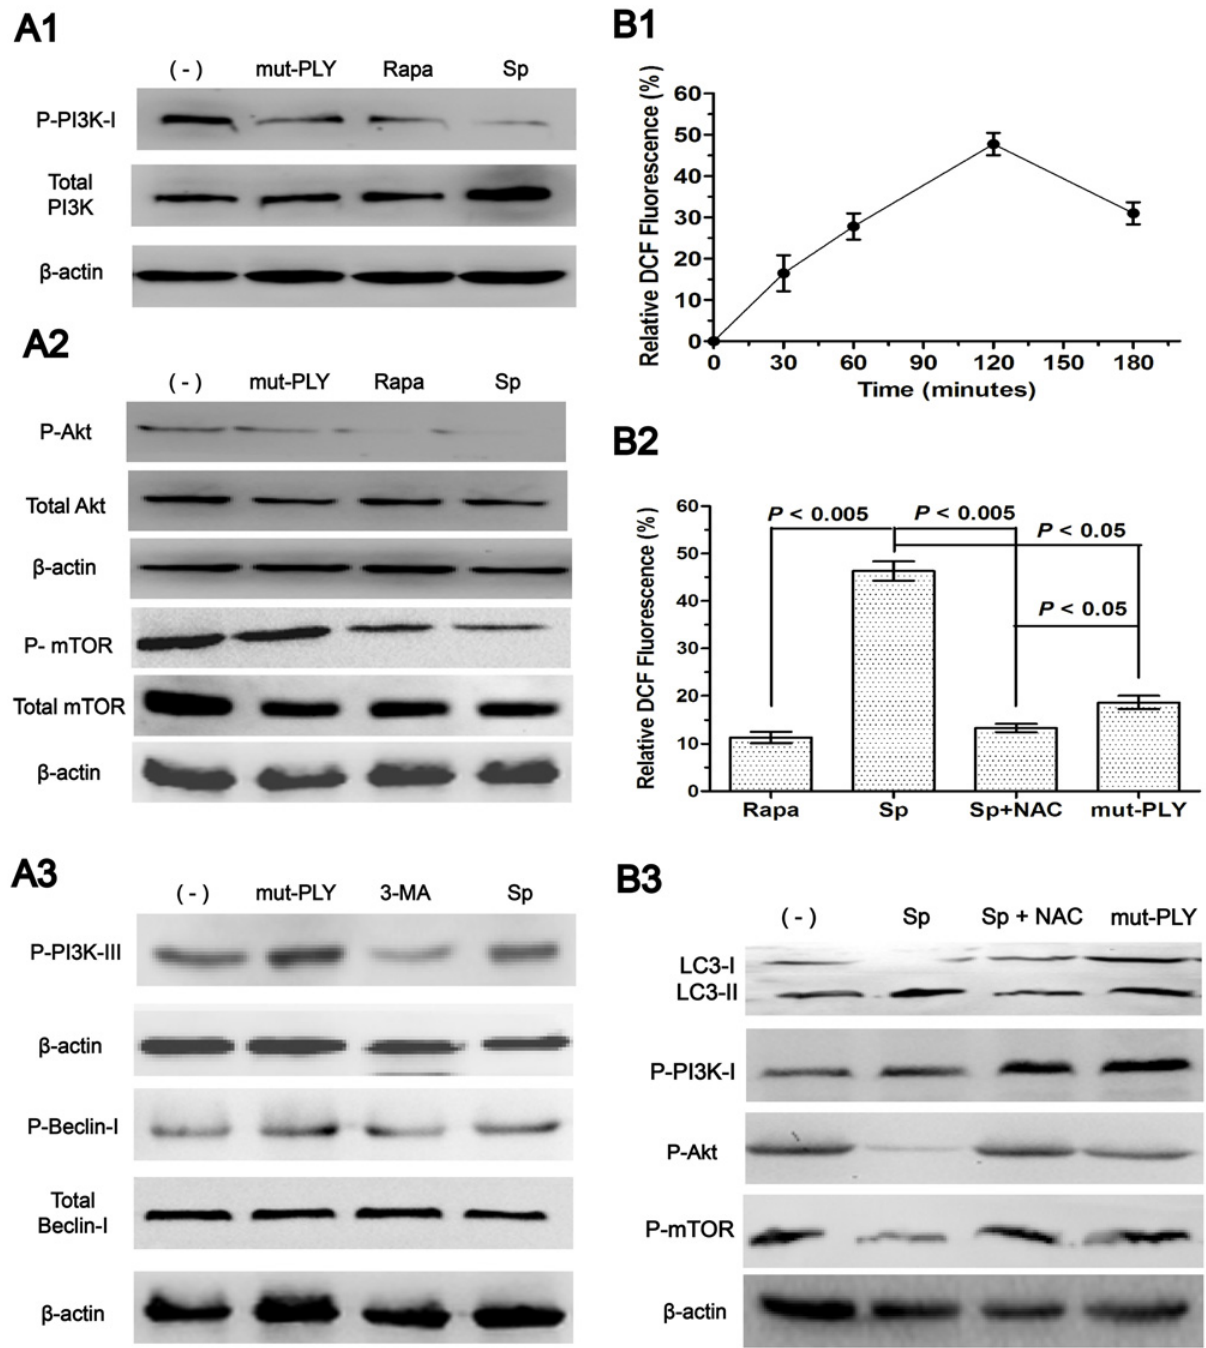
Fig 4. Pneumococcus PLY induces autophagy by inhibiting the PI3K/AKT/mTOR pathway and it is mediated through ROS hypergeneration. (A). Sp infection induced autophagy through the PI3K/Akt/mTOR inhibition pathway. A549 cells were infected with Sp for 1 h. A1. Western blotting of phosphorylated PI3K-I. Sp (st35A)-induced autophagy depends on P-PI3K-I inhibition. A2. Western blotting of phosphorylated Akt and mTOR. Sp inhibits Akt/mTOR signaling in A549 cells. A3. The expression levels of PI3K-III and Beclin 1 were not affected by Sp infection. (B). Sp infection induces ROS hypergeneration. A549 cells were infected with Sp for 1 h and intracellular ROS hypergeneration was observed in A549 cells. B1. A time-dependent intracellular ROS hypergeneration was observed in A549 cells infected with st35A. B2. ROS was significantly increased when the cells were infected with st35A ( p < 0.005). B3. The ROS-specific inhibitor NAC can upregulate PI3K/AKT/mTOR expression. Data are representative of three experiments with similar results. p-PI3K-I: phosphorylated PI3K-I; Rapa: rapamycin; Sp: S . pneumoniae ; mut-PLY: PLY-deficient strain; ROS: reactive oxygen species; NAC: acetylcysteine (ROS inhibitor).